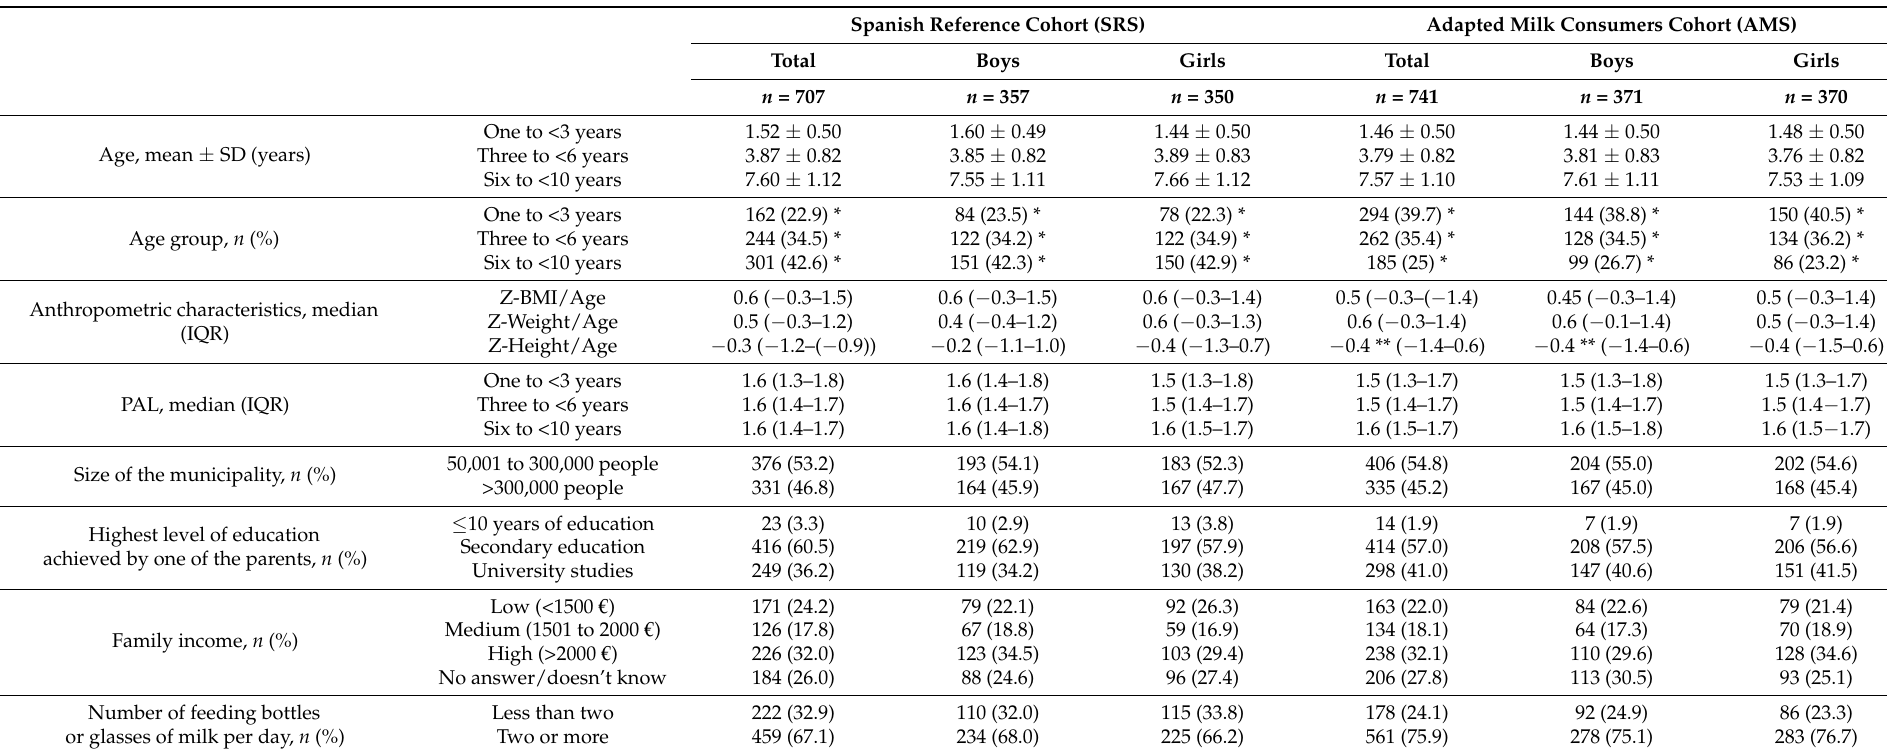
Table 1. Data on personal, anthropometric, and socioeconomic characteristics by sex and age group in the Spanish Pediatric Population (EsNuPI)